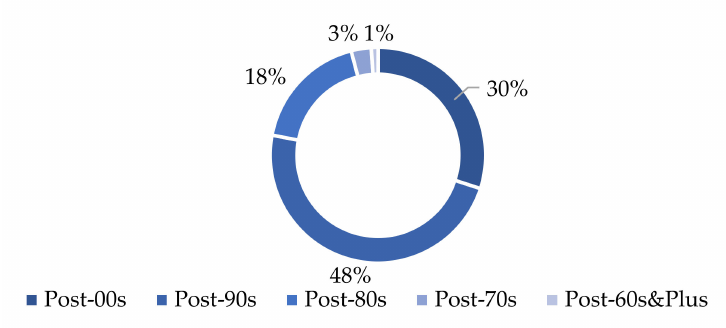
Figure 1. Age distribution of Weibo